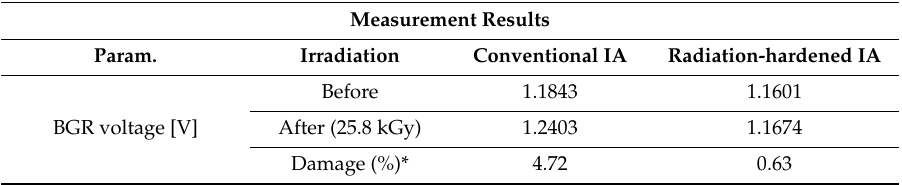
Table 5. Radiation-induced damage by TID e ff ects in the radiation-hardened